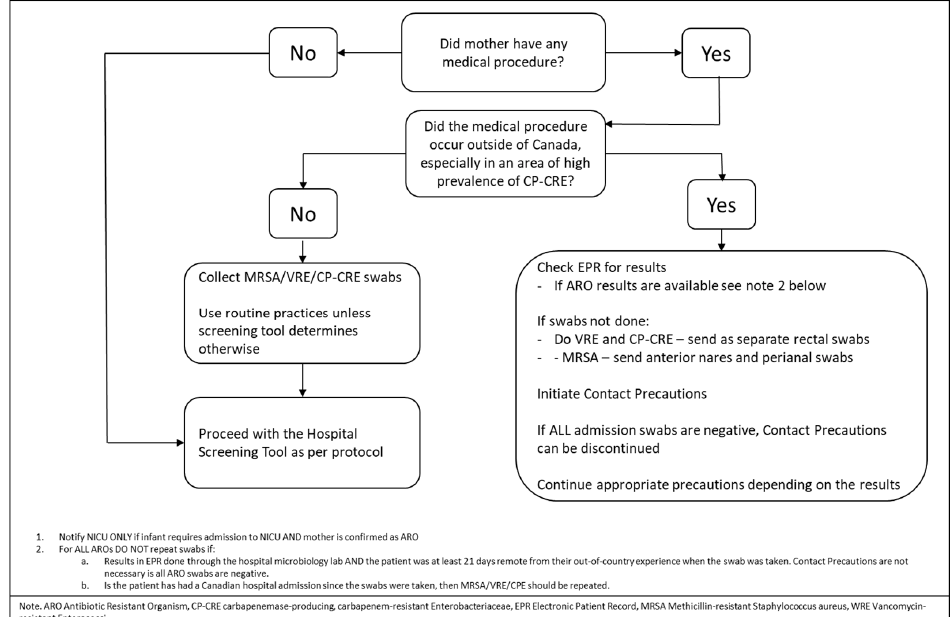
Figure 4. Carbapenemase-producing, carbapenem-resistant Enterobacteriaceae infection and preven- tion algorithm (for use with the hospital screening